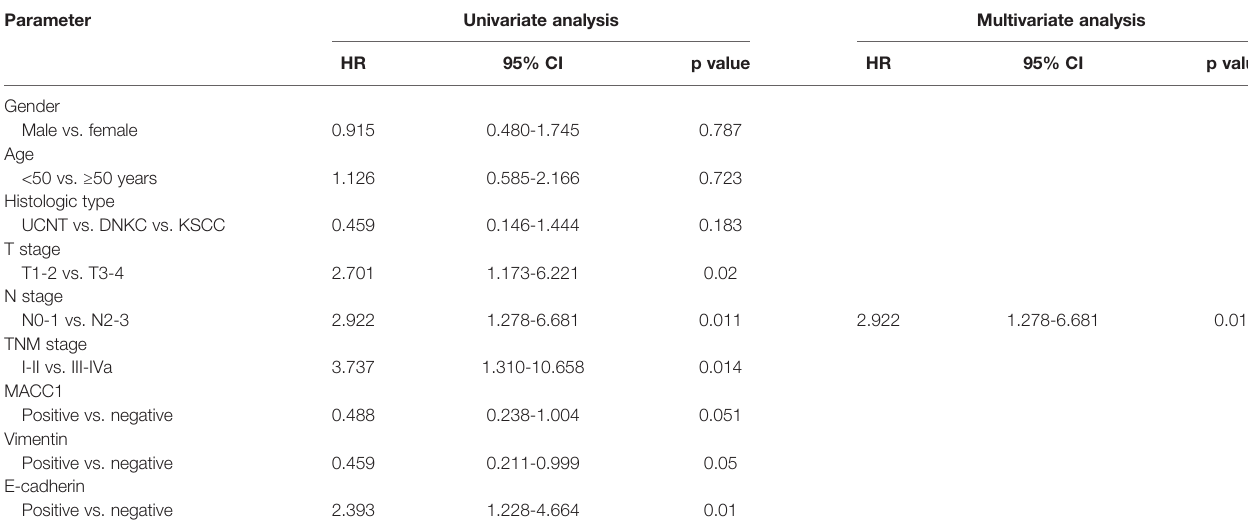
TABLE 3 | Univariate and multivariate analyses of prognostic factors for 5-year relapse-free survival of NPC patients.